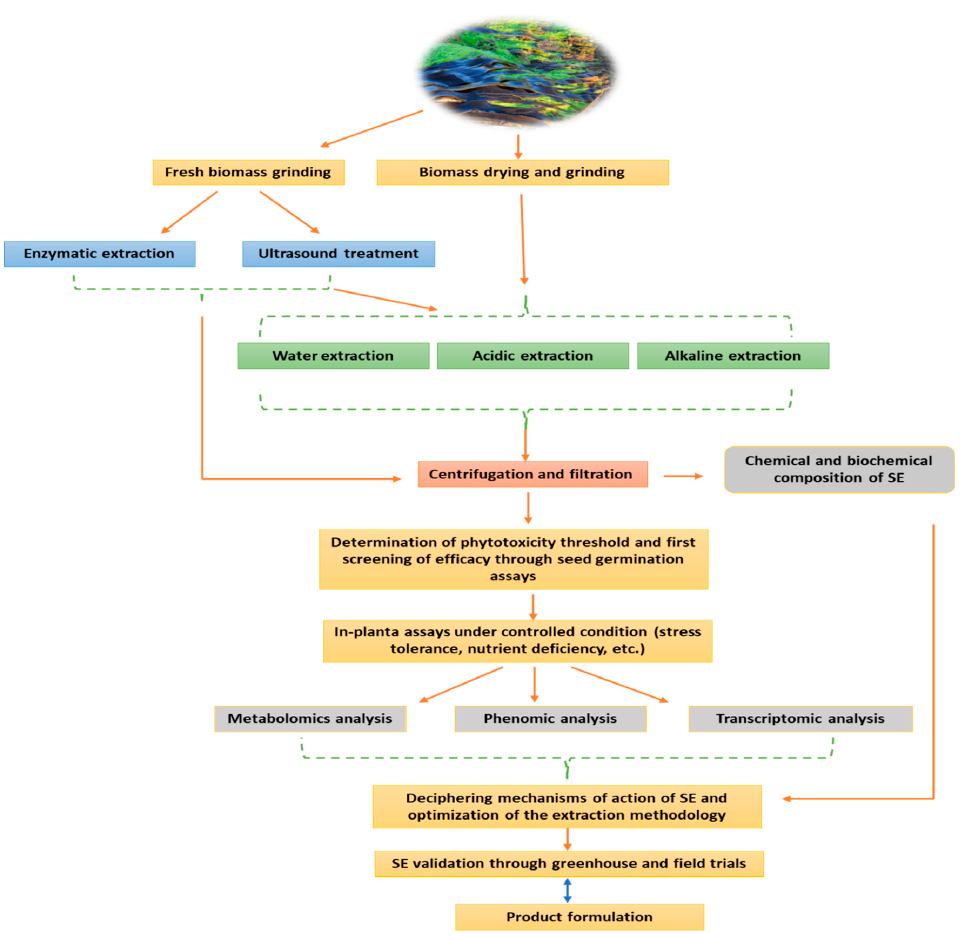
Figure 1. Proposed flowchart of seaweed extraction process from collected algal biomasses until product validation. The flowchart is based on routinely used extraction methodologies as well as high-throughput approaches for the validation of the product efficacy.